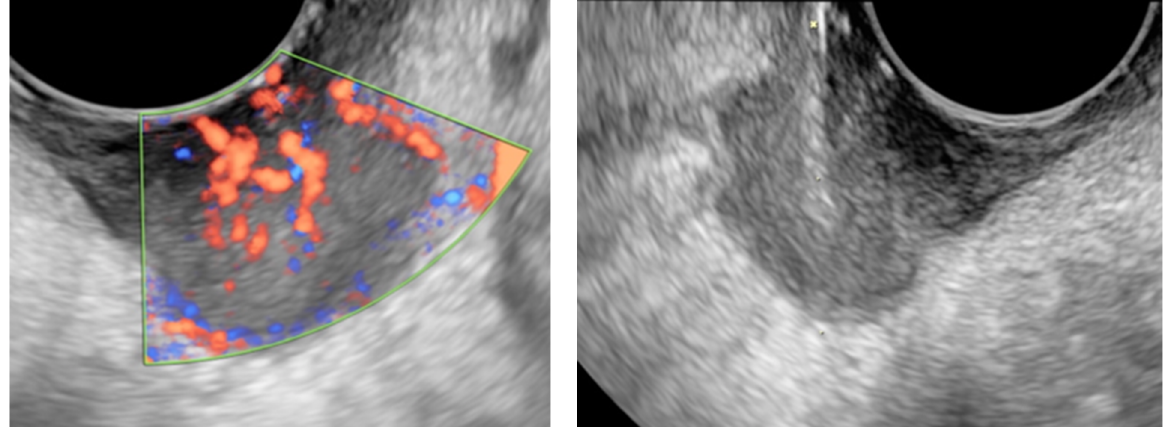
Figure 1. The US image of a highly vascularized cervical squamous cancer relapse ( left ) and the clear image of the tru-cut needle inside the lesion during the procedure ( right ).